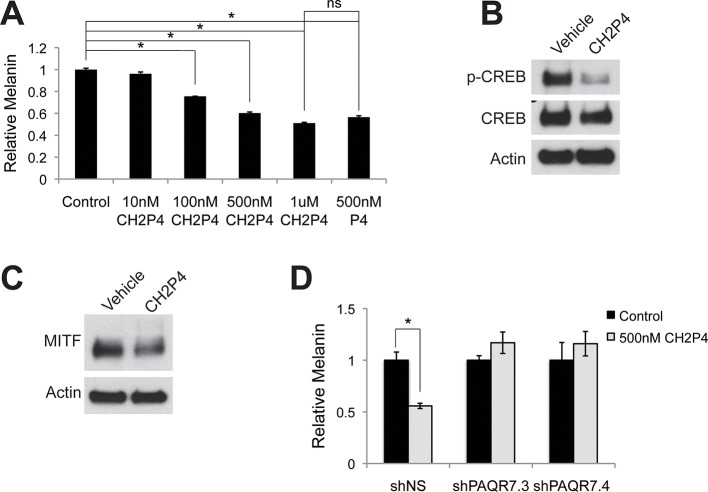
Targeting PAQR7 with specific agonists.(A) Melanin production in response to CH2P4, a specific PAQR7 agonist. (B) Western blot demonstrating a decrease in pCREB after a 30 min CH2P4 treatment. (C) Western blot demonstrating a decrease in MITF after a 16 hr CH2P4 treatment. (D) Melanin assay performed on melanocytes lentivirally transduced with control shRNA or shRNA targeting PAQR7, cells were treated with either vehicle or CH2P4. n=3 biologic replicates for each experiment. Error bars denote +/- s.d., *p<0.05.